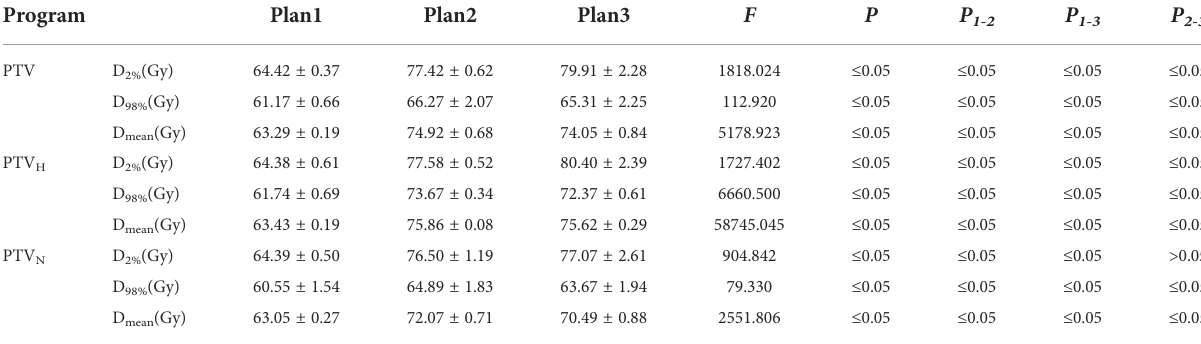
TABLE 3 Comparison of D 2% 、 D 98% and D mean among three